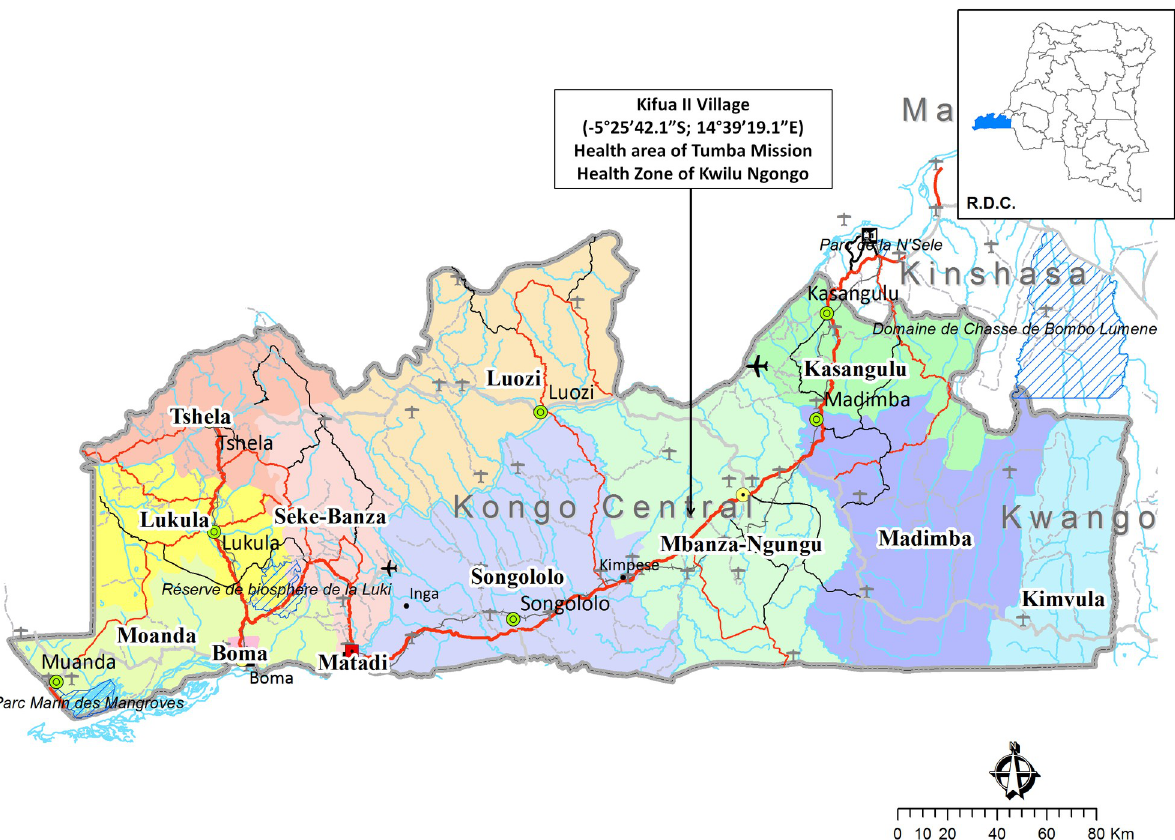
Fig 1. The province of Kongo Central in the Democratic Republic of Congo. Kifua II village, health area of Tumba Mission, Health Zone of Kwilu Ngongo.